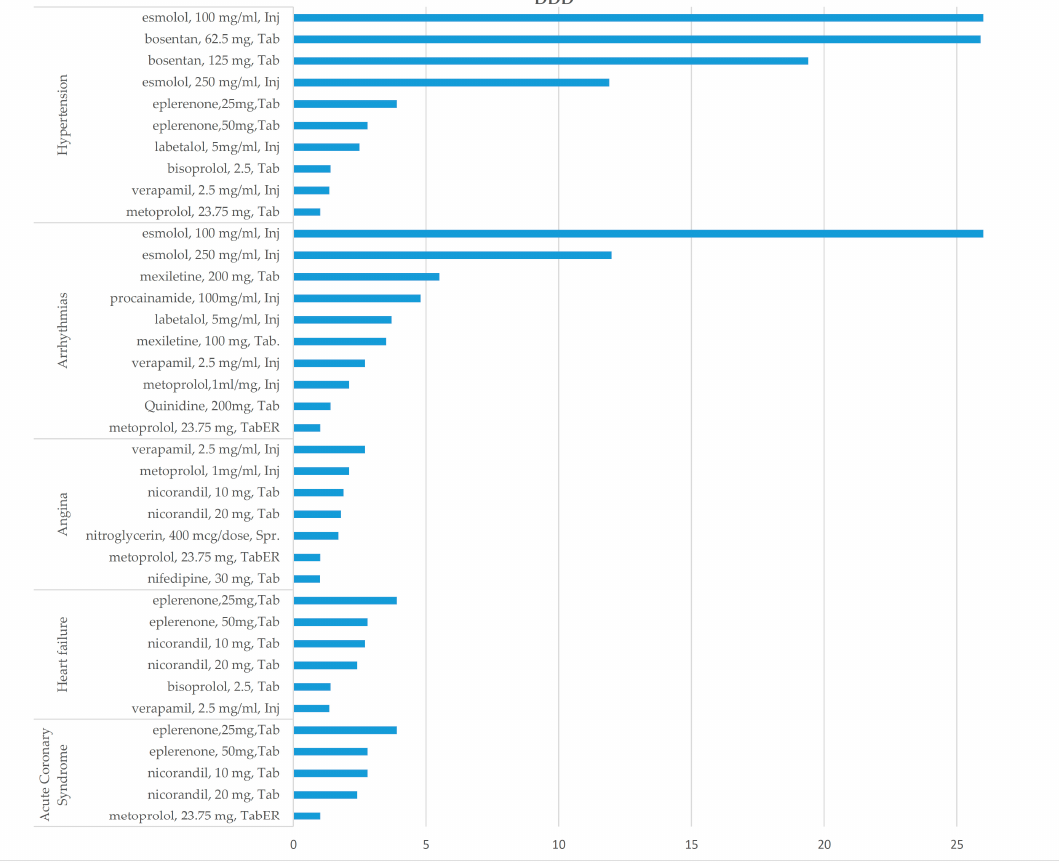
Figure 3. The non-affordable medicines in the defined daily dose (DDD) scenario. Figure 3. The non-a ff ordable medicines in the defined daily dose (DDD)